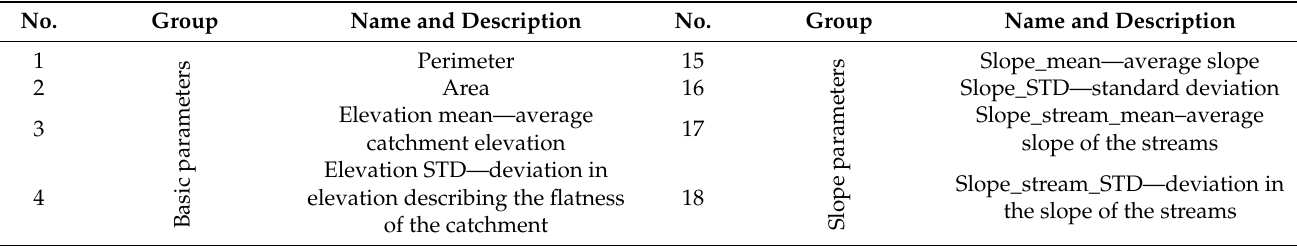
Table 2. List of parameters that enter the SHC classification. Names of each parameter included type of parameter; where relevant, it also contains a description of the type of statistics. The statistics (standard deviation (STD), mean, maximum) are calculated in GIS. Parameters 1–12 are derived from DTM, or in combination with the stream axes, where the slope characteristics (15–18) were identified in the original DTM layer before the stream receded. Parameters 20–24 were obtained from Equations